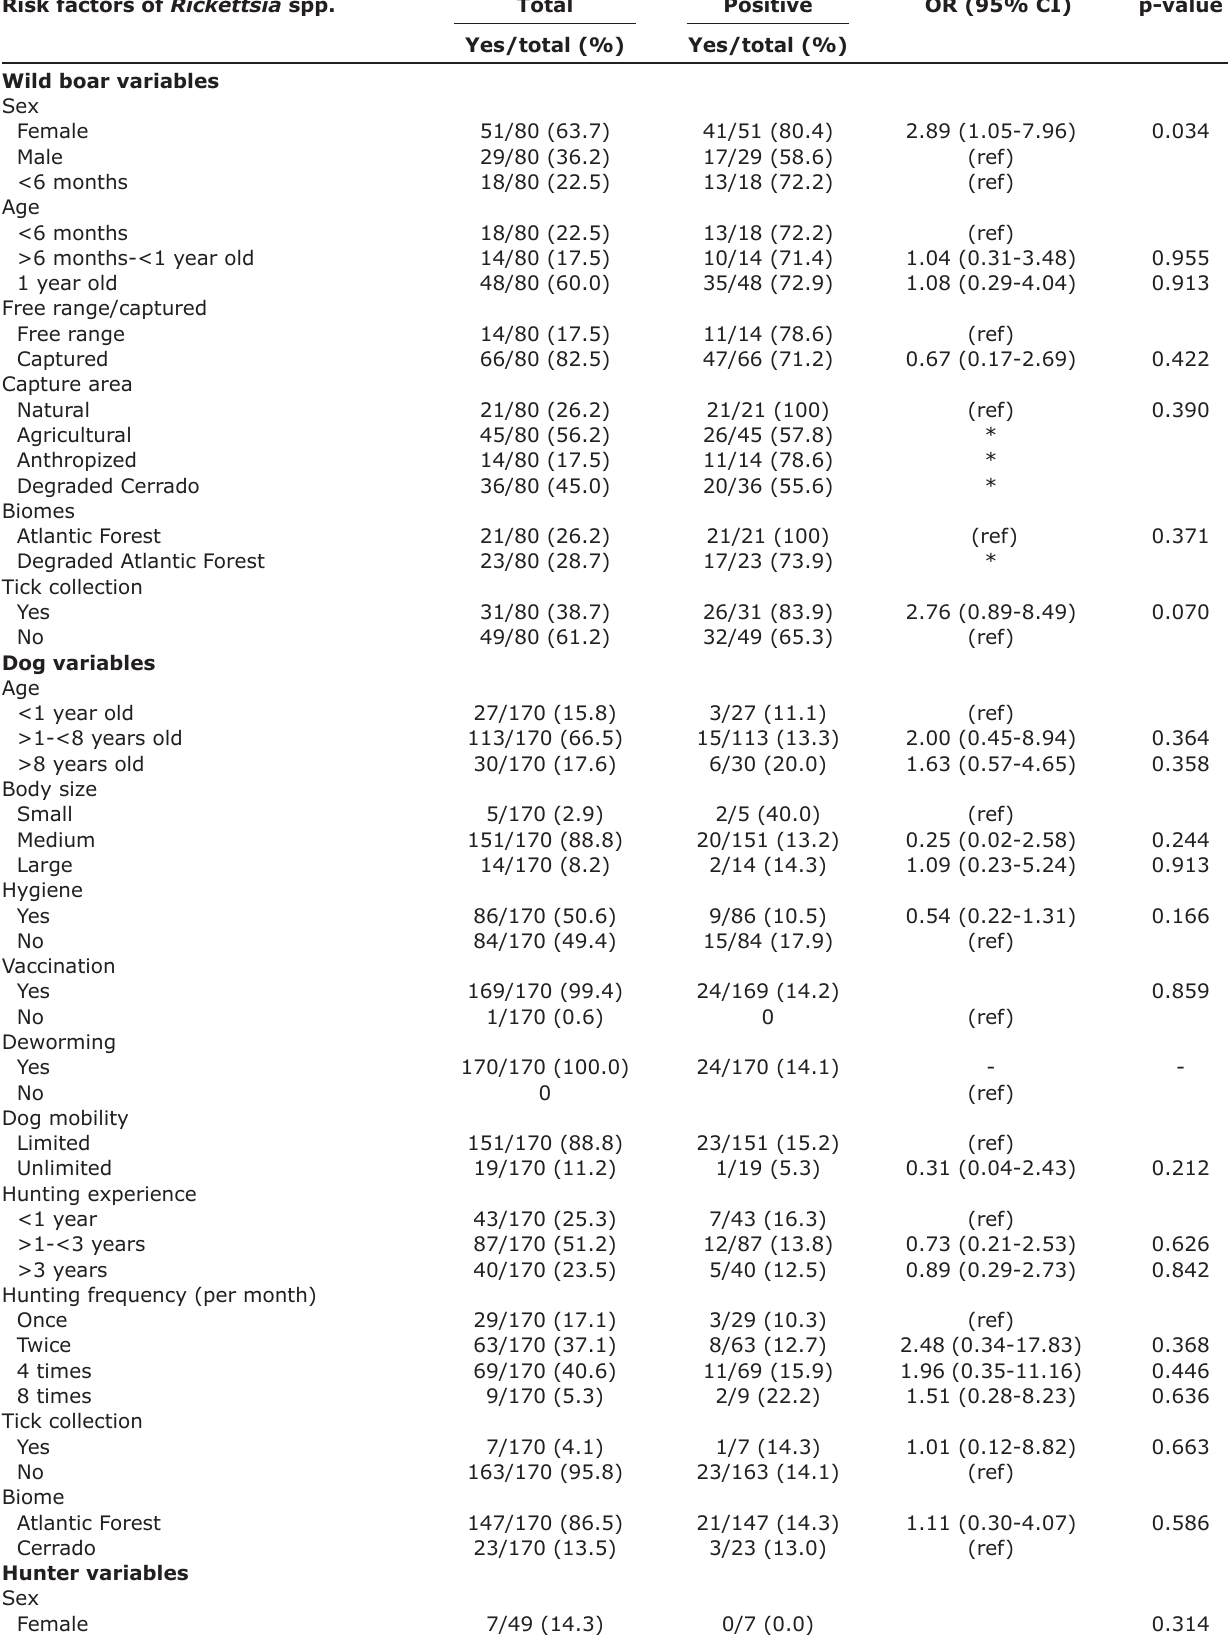
Table-1: Risk factors for seropositivity of anti- Rickettsia spp. antibodies in wild boars, hunting dogs, and hunters. Risk factors of Rickettsia